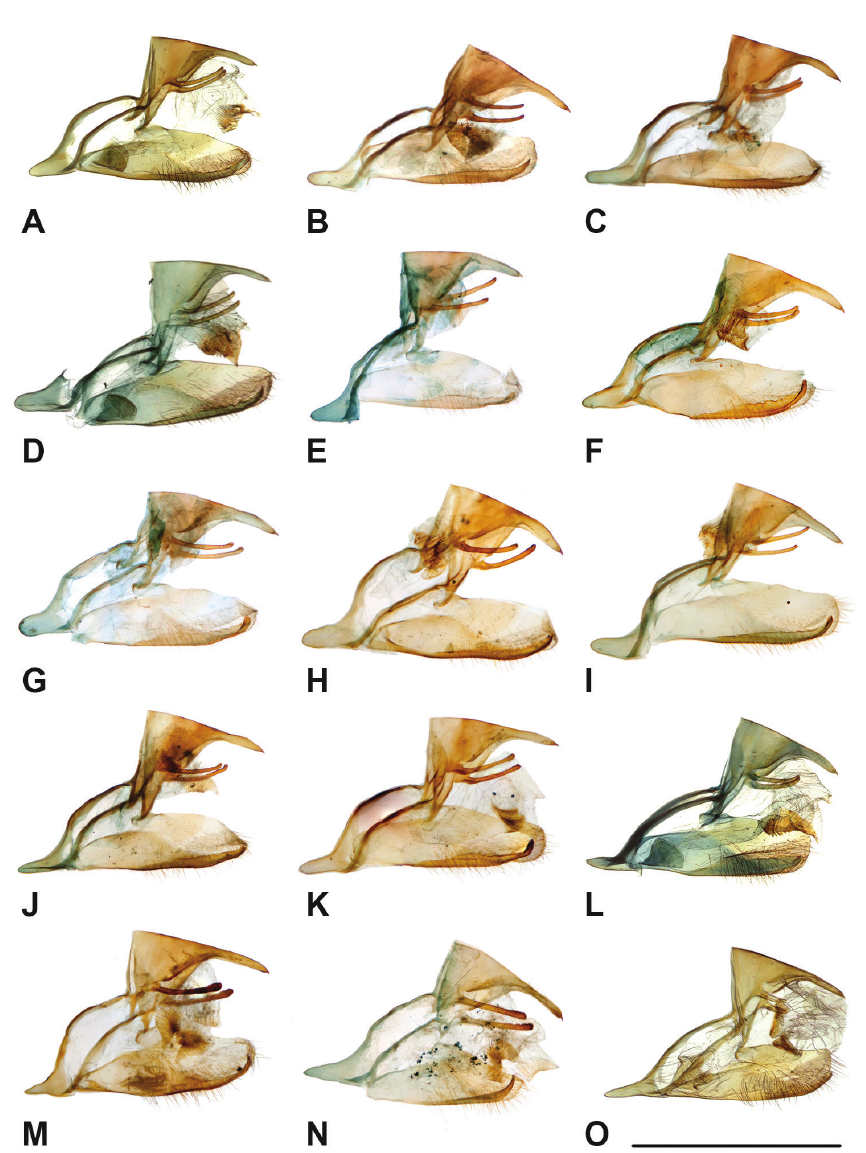
Figure 23. A hypermnestra hypermnestra NHM Indonesia: West Java, Bogor B hypermnestra hypermnestra MCZ Indonesia: Maluku, Seram C hypermnestra fraterna MCZ Sri Lanka: Western Province D hyperm- nestra cottonis NHM India: Andaman Islands E hypermnestra tinctoria NSYSU Thailand: Trang, Khao Chong F hypermnestra hainana NSYSU Taiwan: Kaohsiung G hypermnestra discrepans NSYSU Peninsular Malaysia: Penang H hypermnestra orientalis MCZ Indonesia: East Nusa Tenggara, Flores I hypermnestra baliensis NSYSU Indonesia: Bali J hypermnestra sumbana MCZ Indonesia: East Nusa Tenggara, Sumba K hypermnestra timorensis MCZ Indonesia: East Nusa Tenggara, Timor L caudata NHM Myanmar (specimen is likely mislabeled) M nepheronides nepheronides MCZ Indonesia: East Nusa Tenggara,